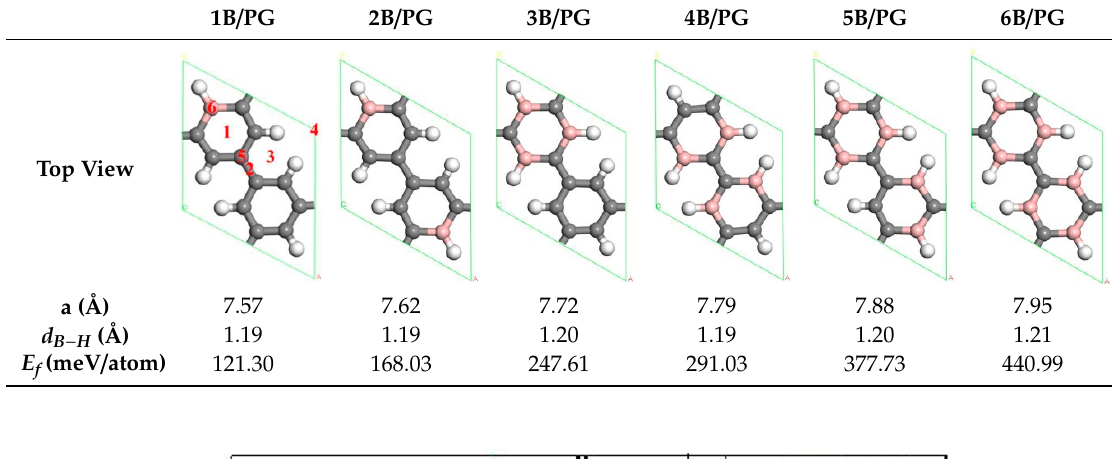
Table 1. Optimized geometries, lattice constants, representative B-H bond lengths, and formation energies of the B-doped porous graphene (PG) system. Note: Gray, white and pink balls represent C, H and B atoms, respectively.